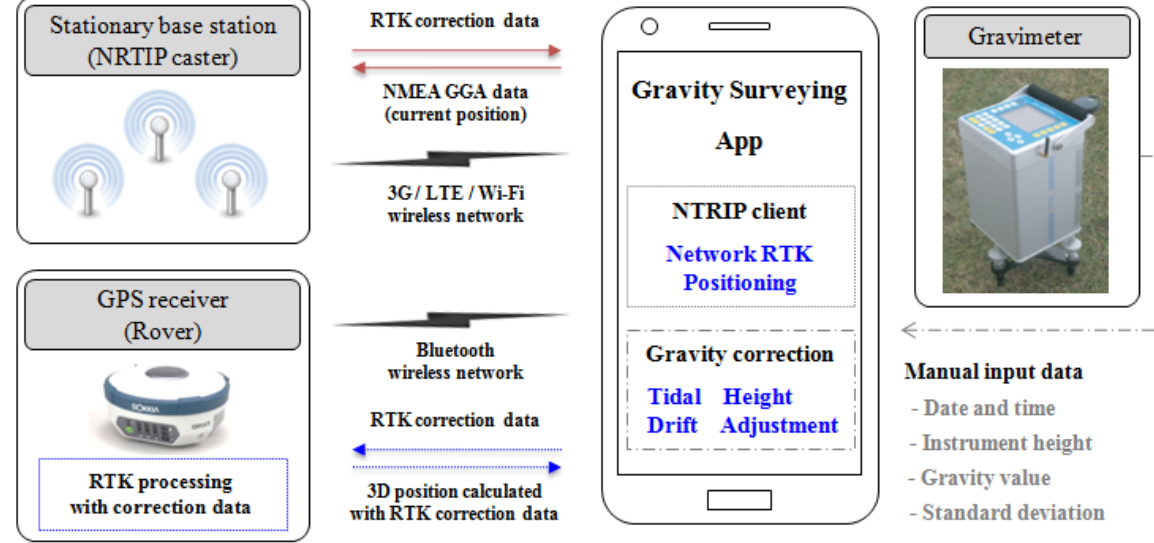
Figure 4. Application design overview consisting of NTRIP client and gravity